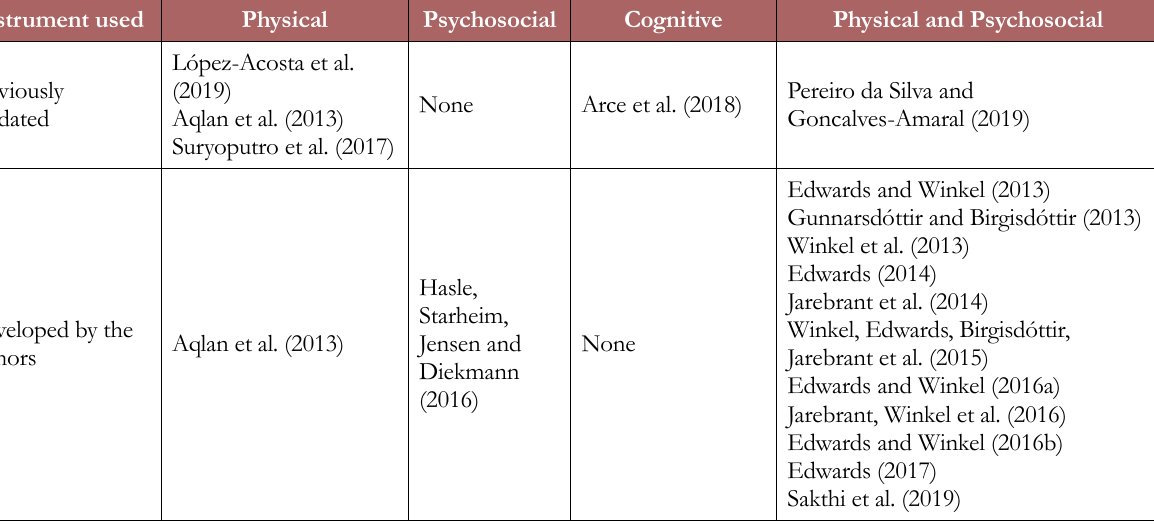
Table 2. Types of instruments applied, and ergonomic factors analyzed in